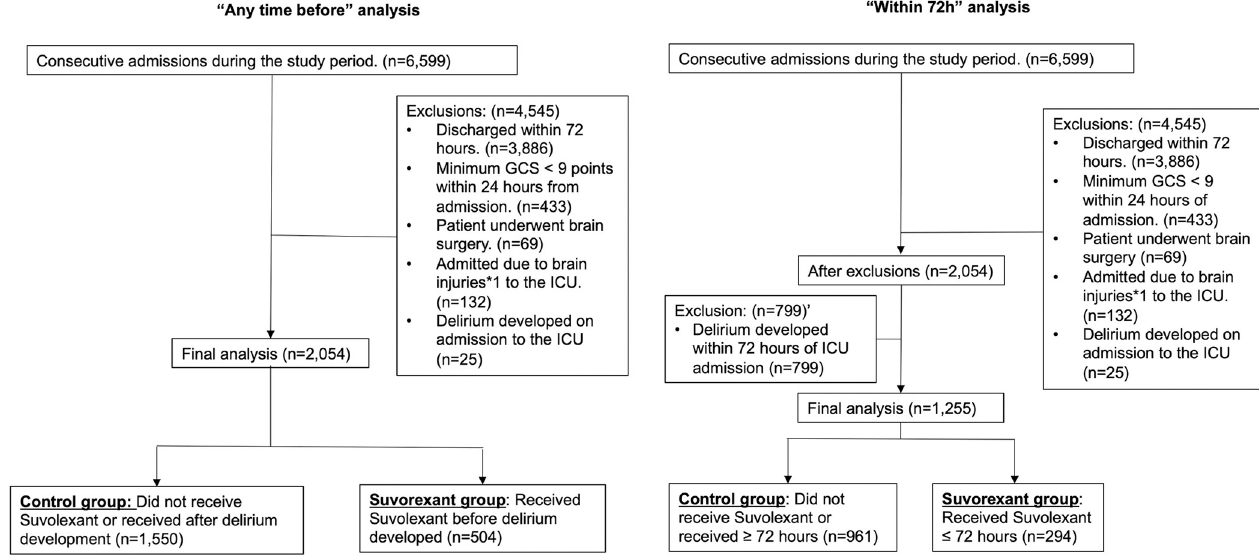
Fig 2. Patient eligibility and exclusions. a. Patient flow for the “any time before” analysis. b. Patient flow for the “within 72h” analysis.